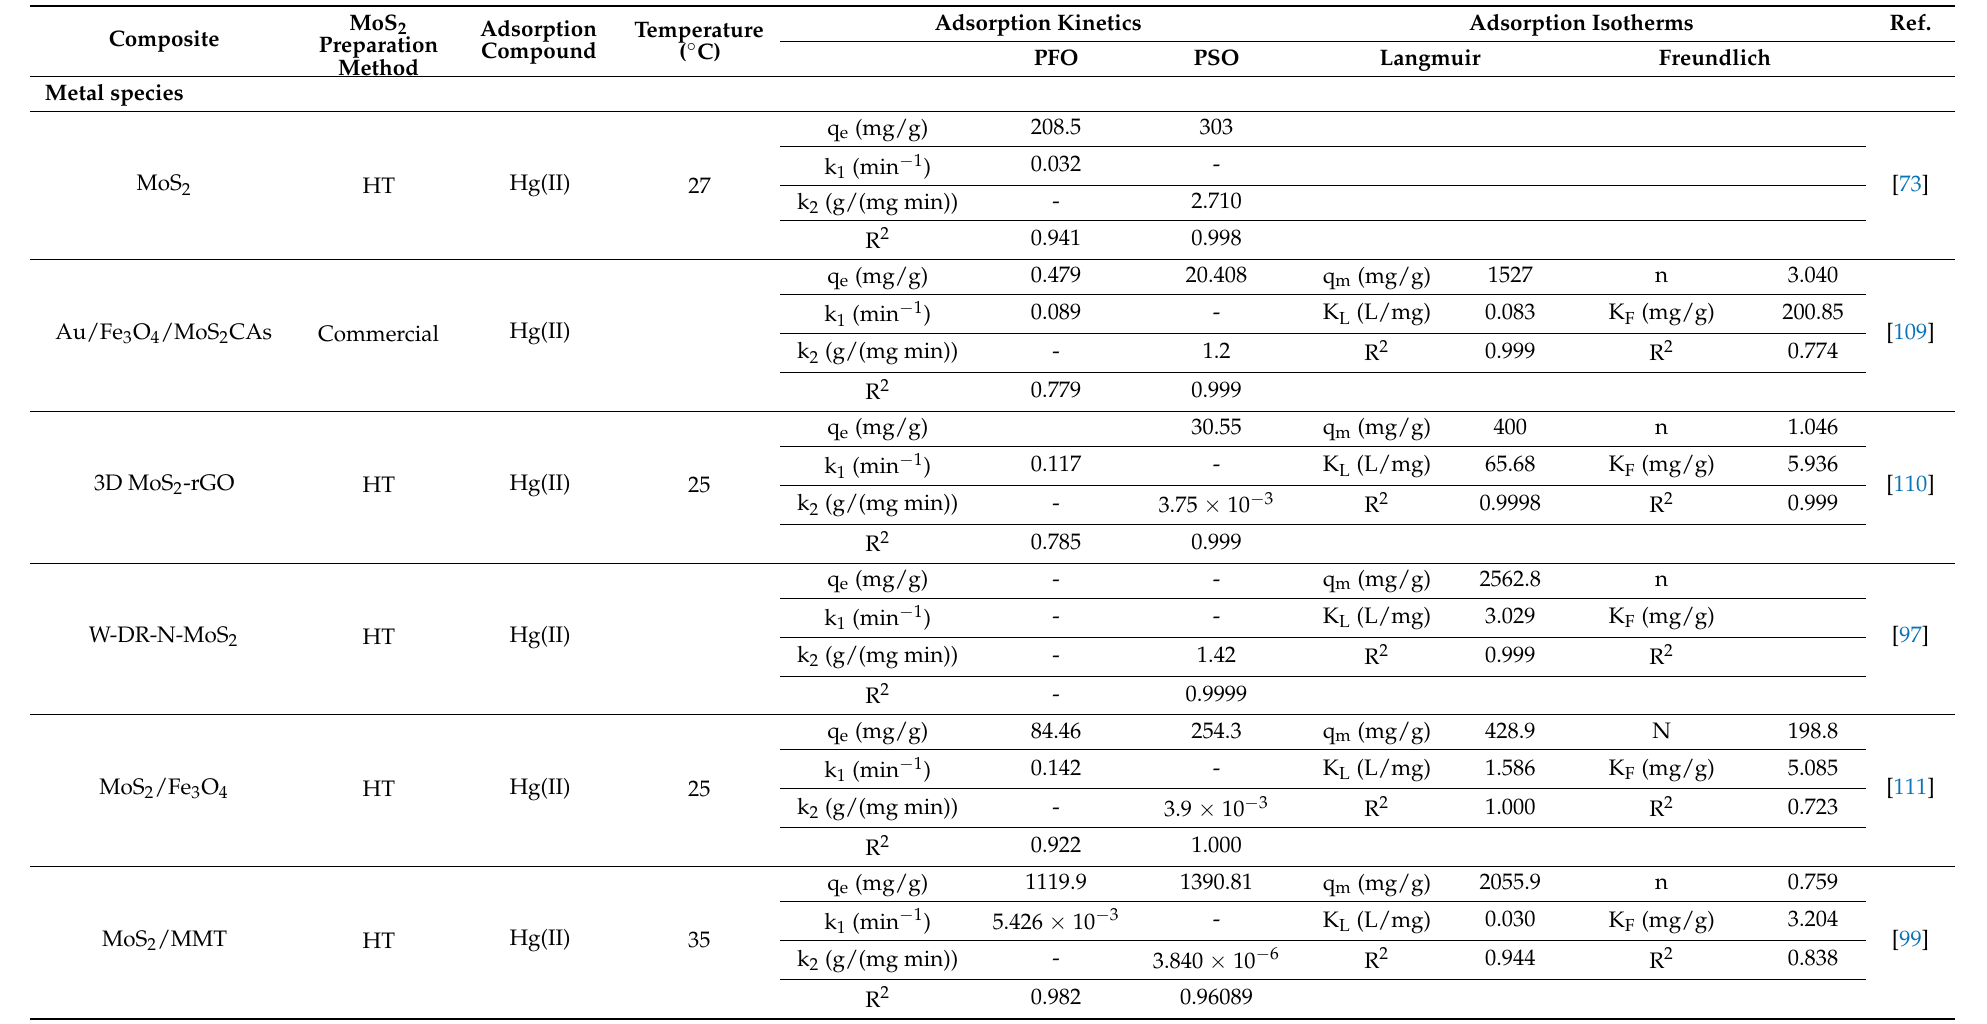
Table 1. Kinetics and equilibrium parameters from the fitted models in adsorption studies for the removal of metal ion species and organic contaminants, using MoS 2 -based